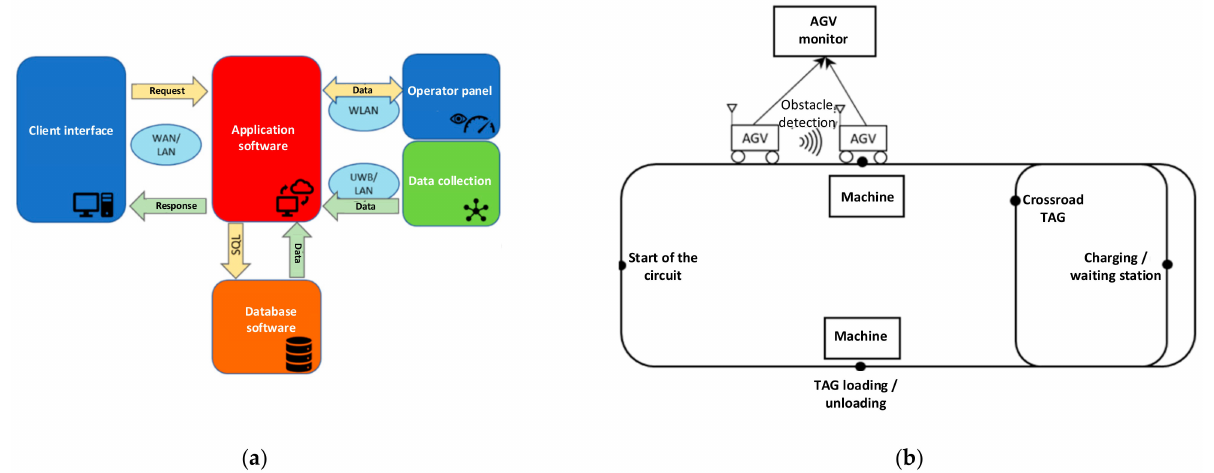
Figure 8. Illustration: ( a ) automatic data collection module architecture; ( b ) tag distribution on the AGV